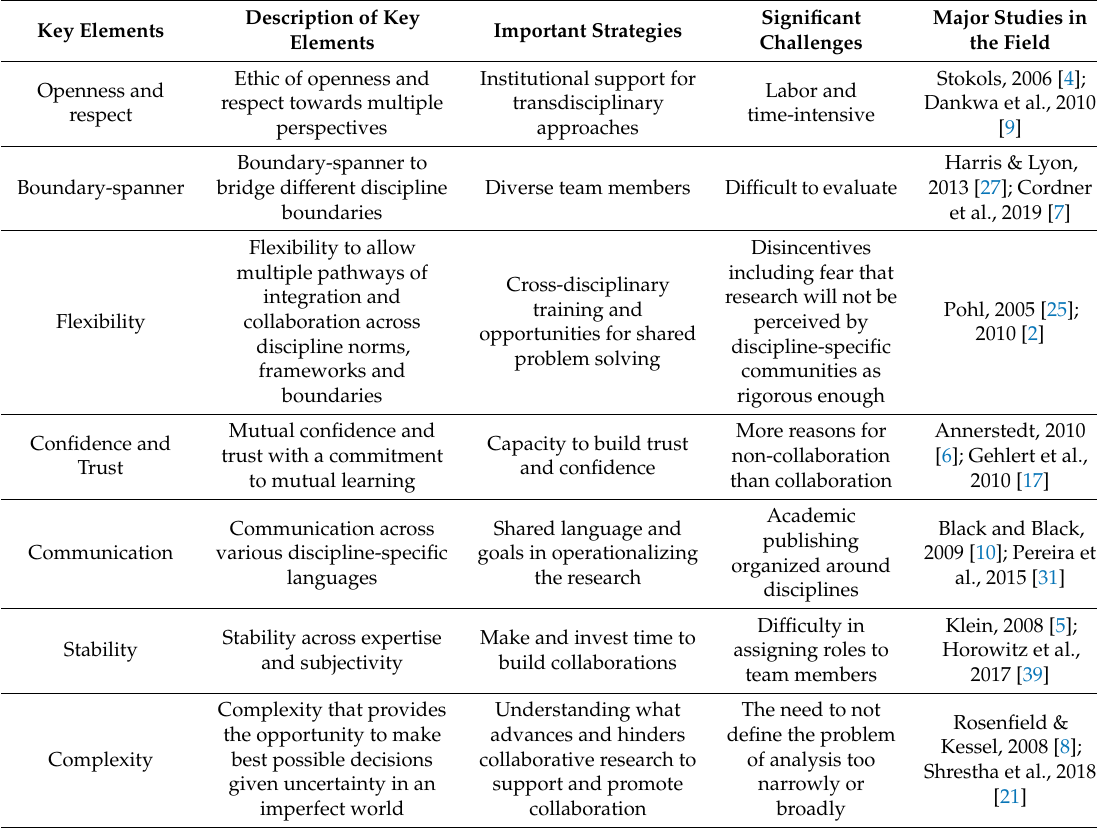
Table 1. Key elements and descriptions, strategies, and challenges for understanding and doing transdisciplinary research with major studies from the extant